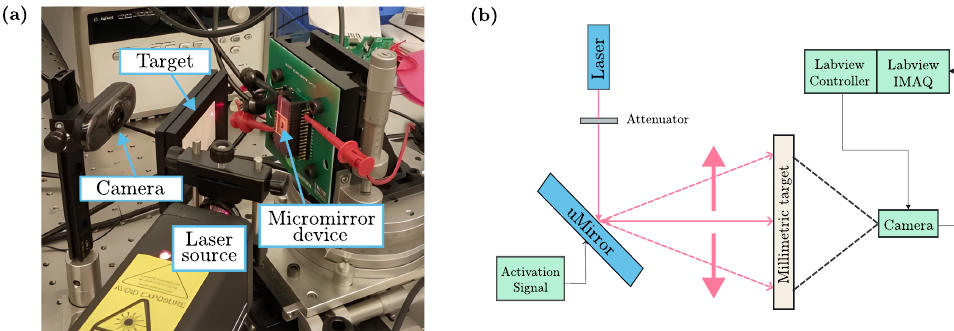
Figure 2. Experimental setup ( a ) and schematic representation of the measurement technique adopted ( b ) for collecting and postprocessing experimental data [37].